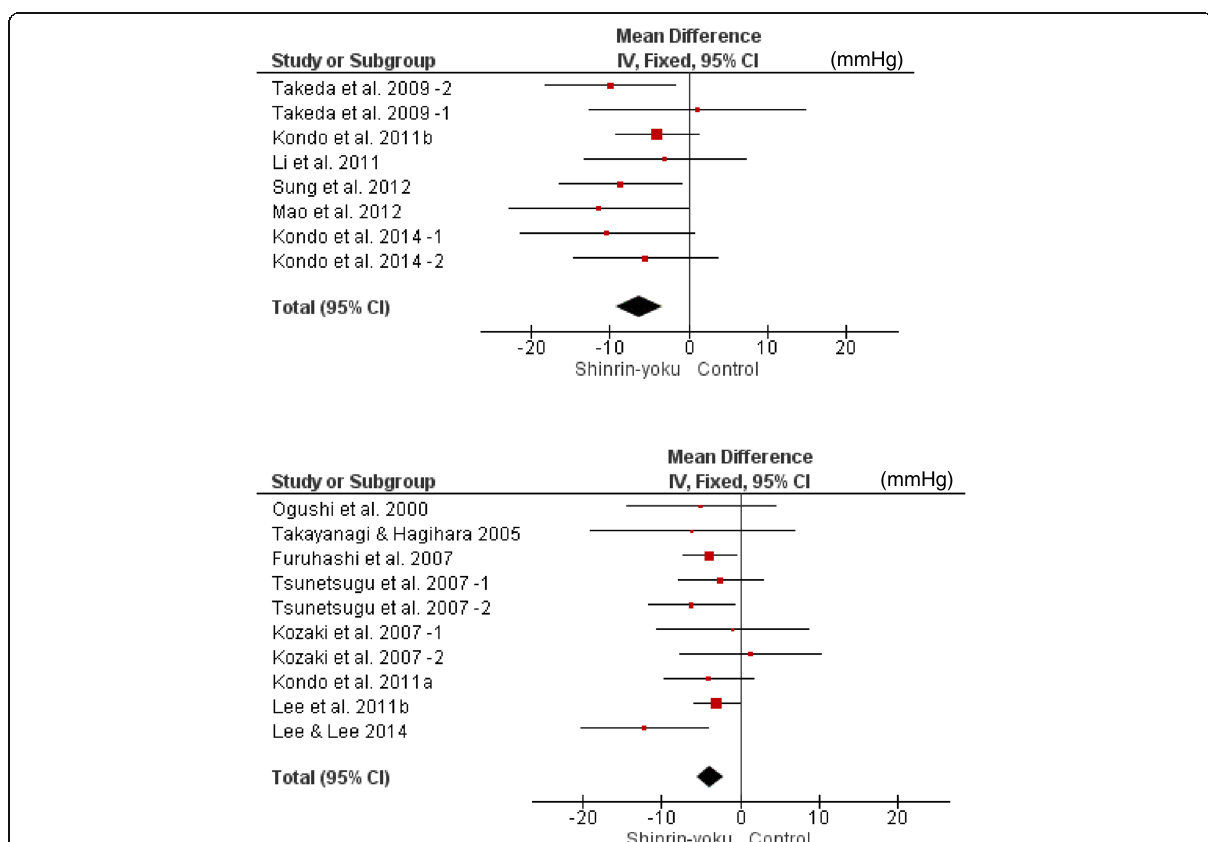
Fig. 3 Two forest plots of the change in SBP (mmHg) in the two subgroup analyses of SBP levels of 1) ≥ 130 and 2) < 130 mmHg before